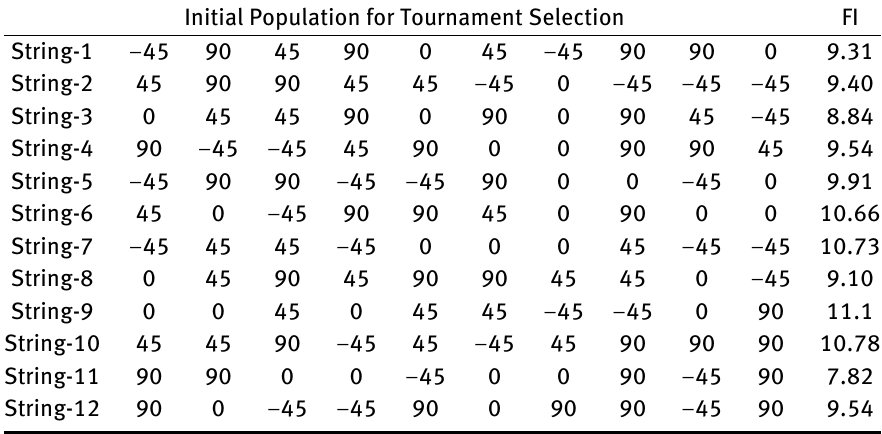
Table 6: Randomly Generated Initial Population Initial Population for Tournament